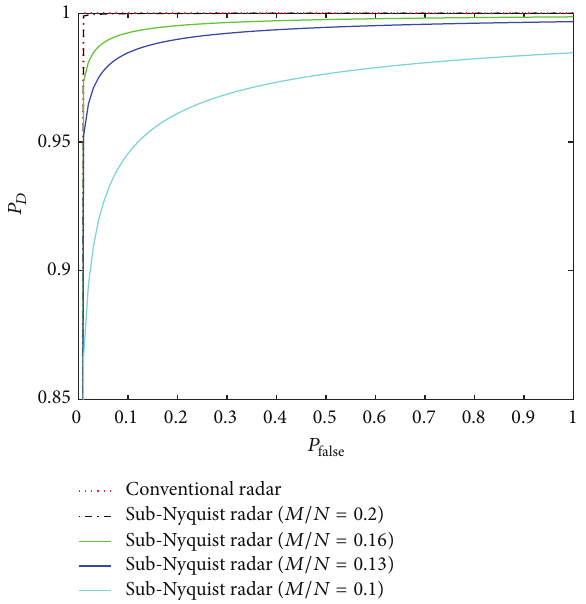
Figure 5: Comparison of detection performance between sub- Nyquist radar and conventional radar.